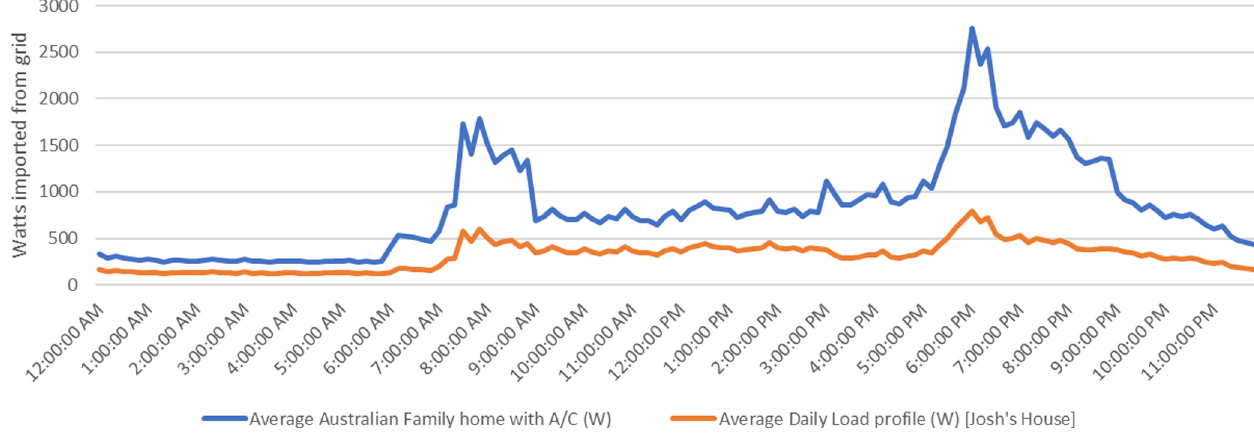
Fig. 1. Josh ’ s House load pro fi le (without PV or DESS) vs. typical Australian load pro fi le. Table 2. Josh ’ s House grid reliance – impact of PV and DESS. Grid reliance Load only With PV